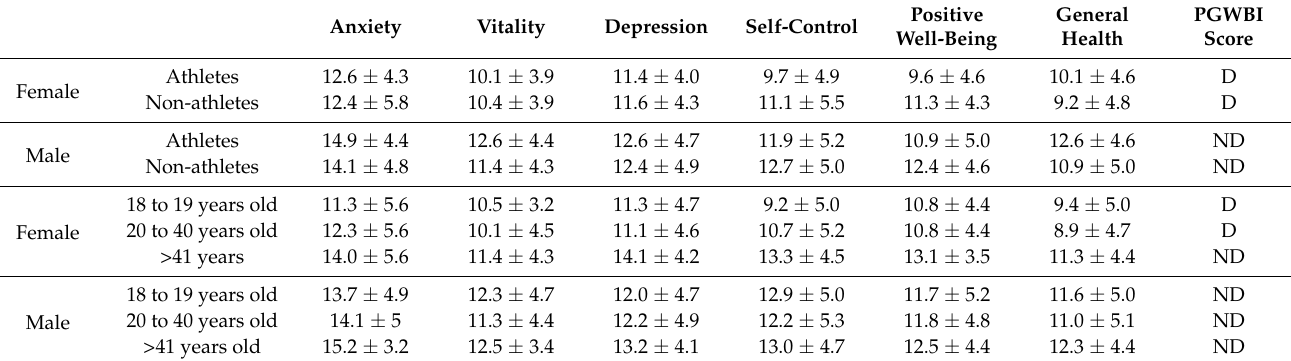
Table 4. Comparison of the effect of sex vs. population and sex vs. age on the dimensions of psychological